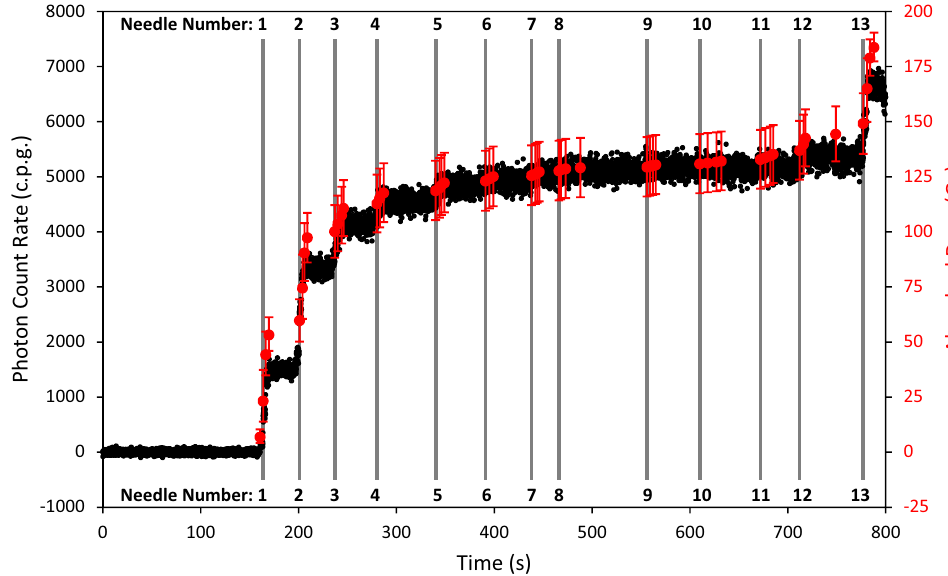
Figure 6. Photon count rate (primary vertical axis) and Absorbed Dose (secondary vertical against) plotted as a function of time, over the course of an I-125 implantation procedure in a 3D anthropomorphic phantom. The real-time PCR data are displayed as black dots, expected absorbed dose readings from the TPS are displayed as solid red circles (one per implanted seed), and vertical grey lines represent each of the 13 peripheral